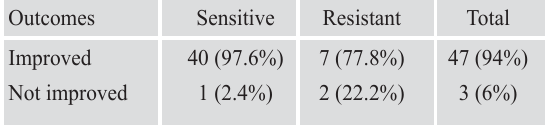
Table III: Outcomes of treatment in azithromycin group based on sensitivity (n=50) Outcomes